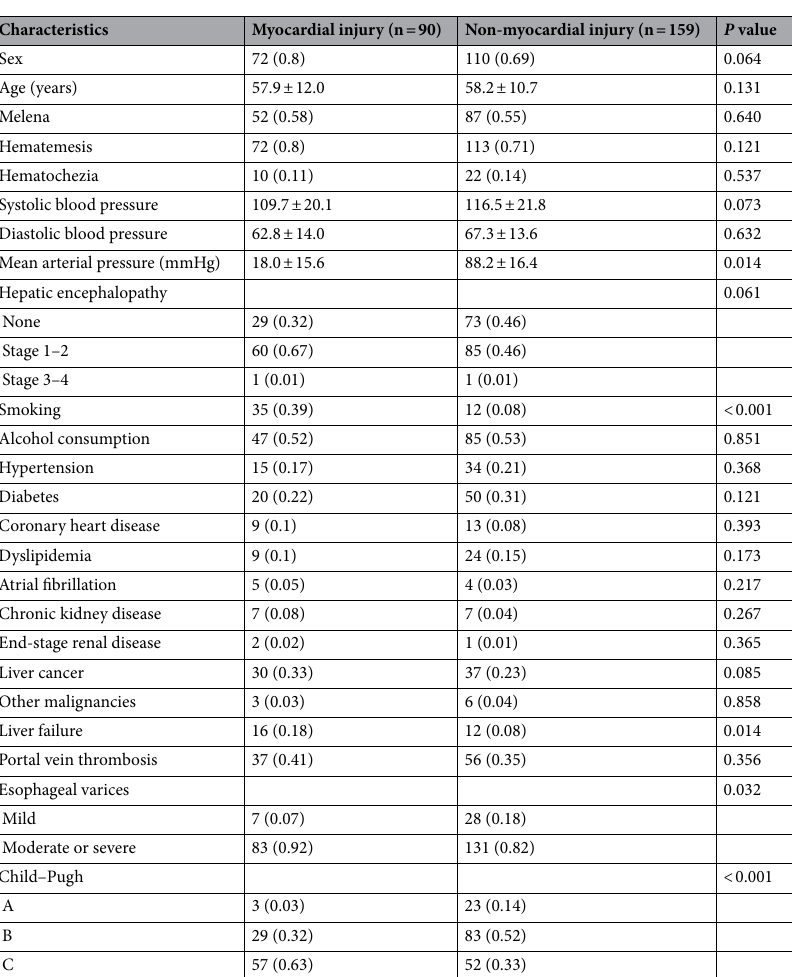
Table 3. Baseline characteristics of patients in the myocardial injury group and non-myocardial injury group.